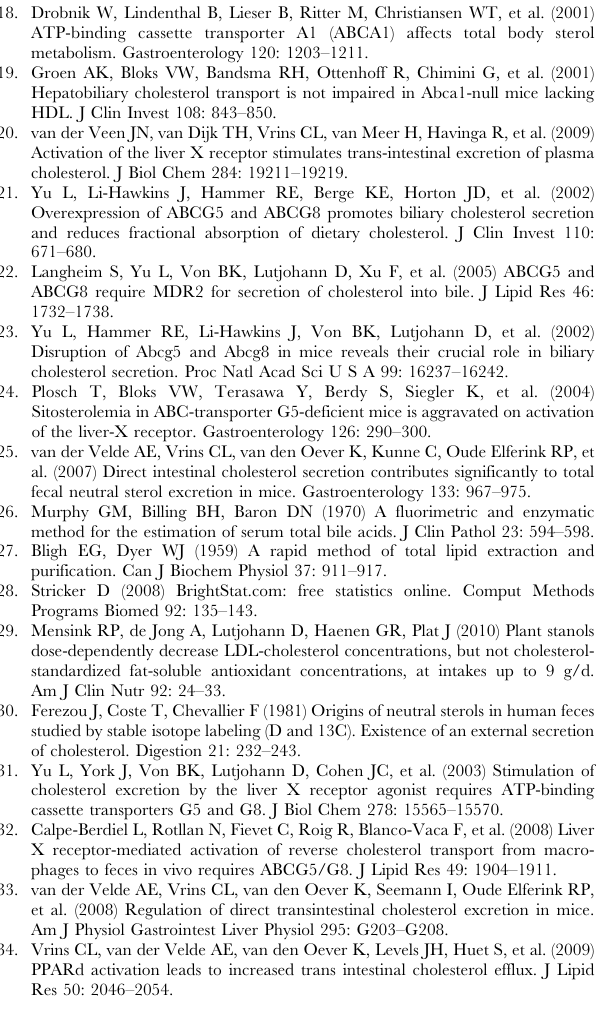
Table S1 Composition of the semi-synthetic diet. 1 Vitamin mix: vitamine A 18.0 IU/g; vitamine D 2.0 IU/g; vitamine D3 2.0 IU/g; vitamine E 62.67 mg/kg; vitamine